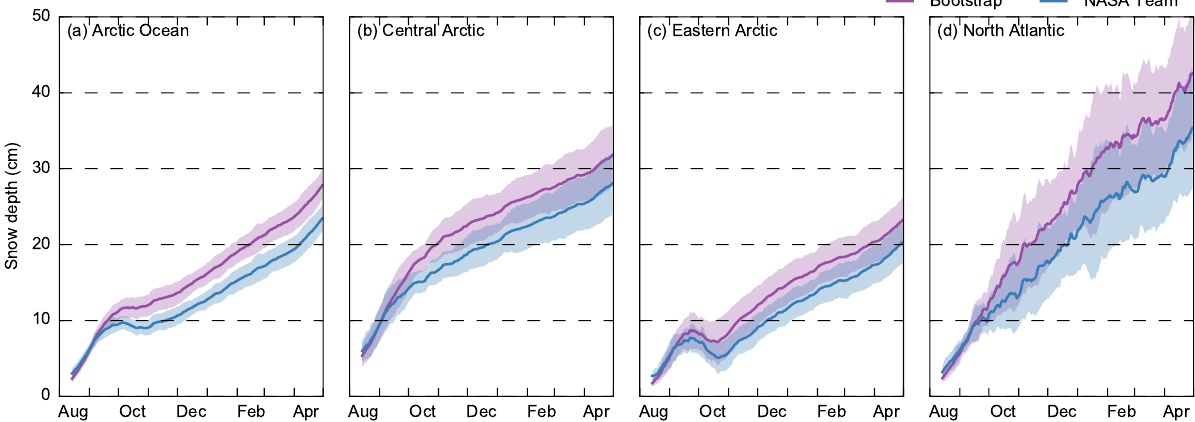
Figure 13. Seasonal snow depth evolution across the four study regions (shown in Fig. 5), initiated from 15 August 2000 to 2014 and run until 1 May of the following year, forced by the Bootstrap (magenta) and NASA Team (blue) ice concentration datasets. The thick lines show the mean (daily) regional snow depths over this time period, while the shaded areas represent interannual variability (1 standard deviation). All model runs use the default/MEDIAN-SF configuration.